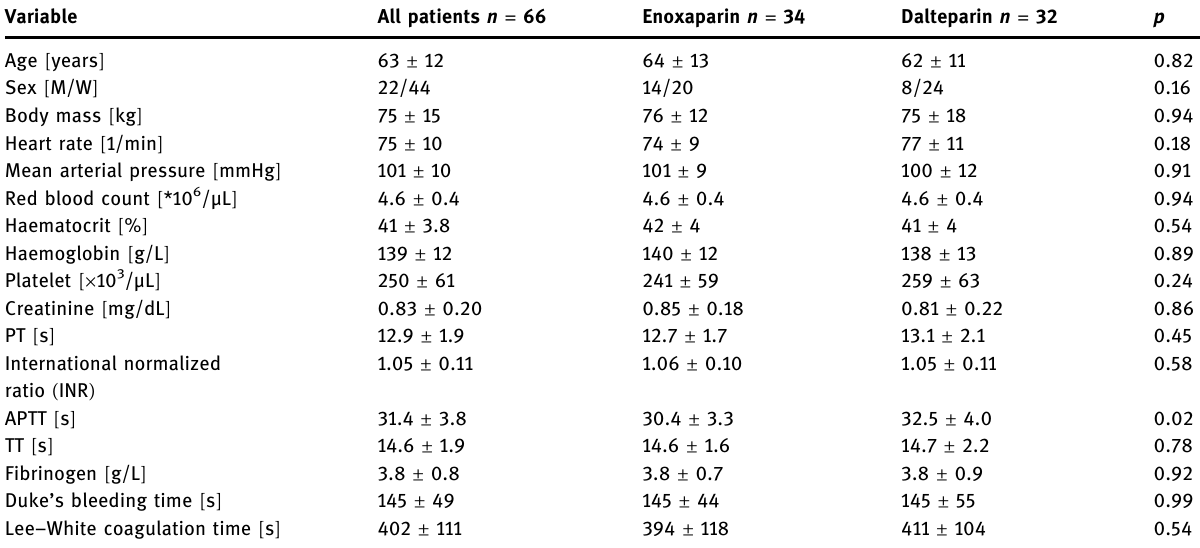
Table 1: Patients ’ basic characteristic before surgery Variable